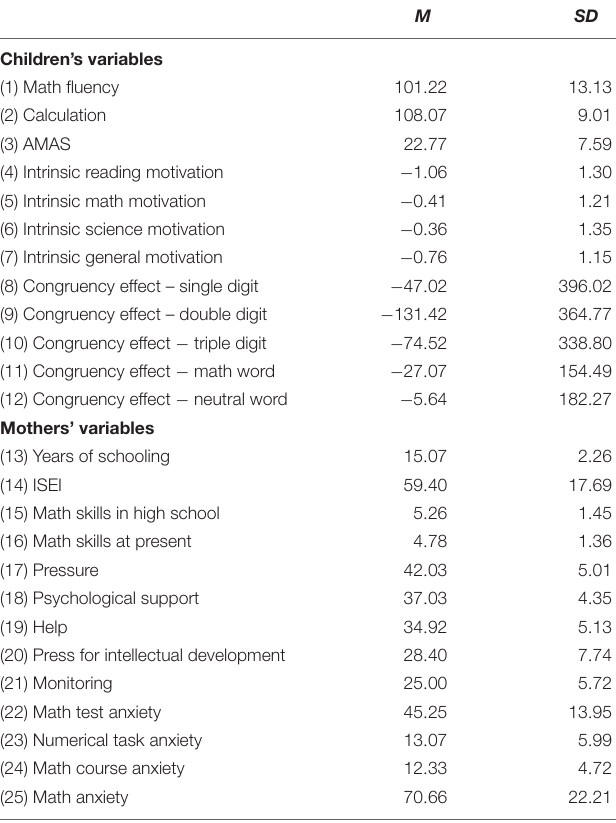
TABLE 1 | Descriptive statistics of the research